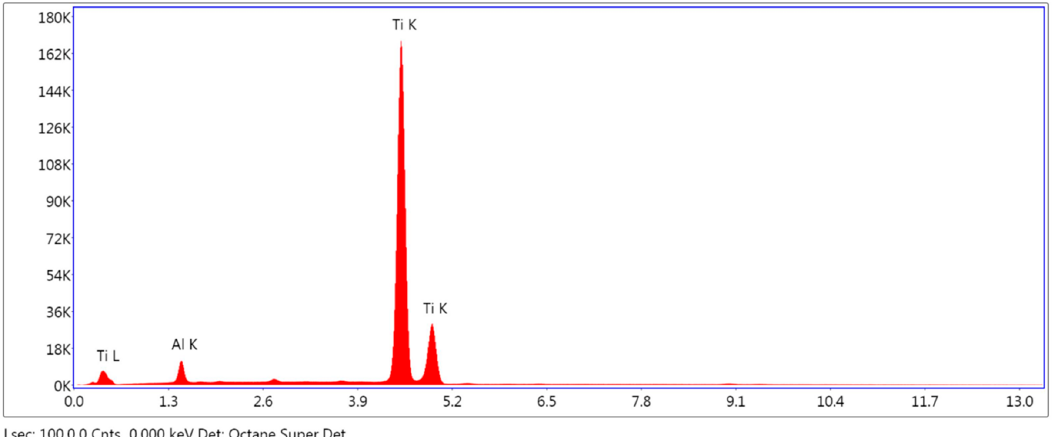
Figure 10. Energy dispersive spectroscopy analysis of HA / TCP.